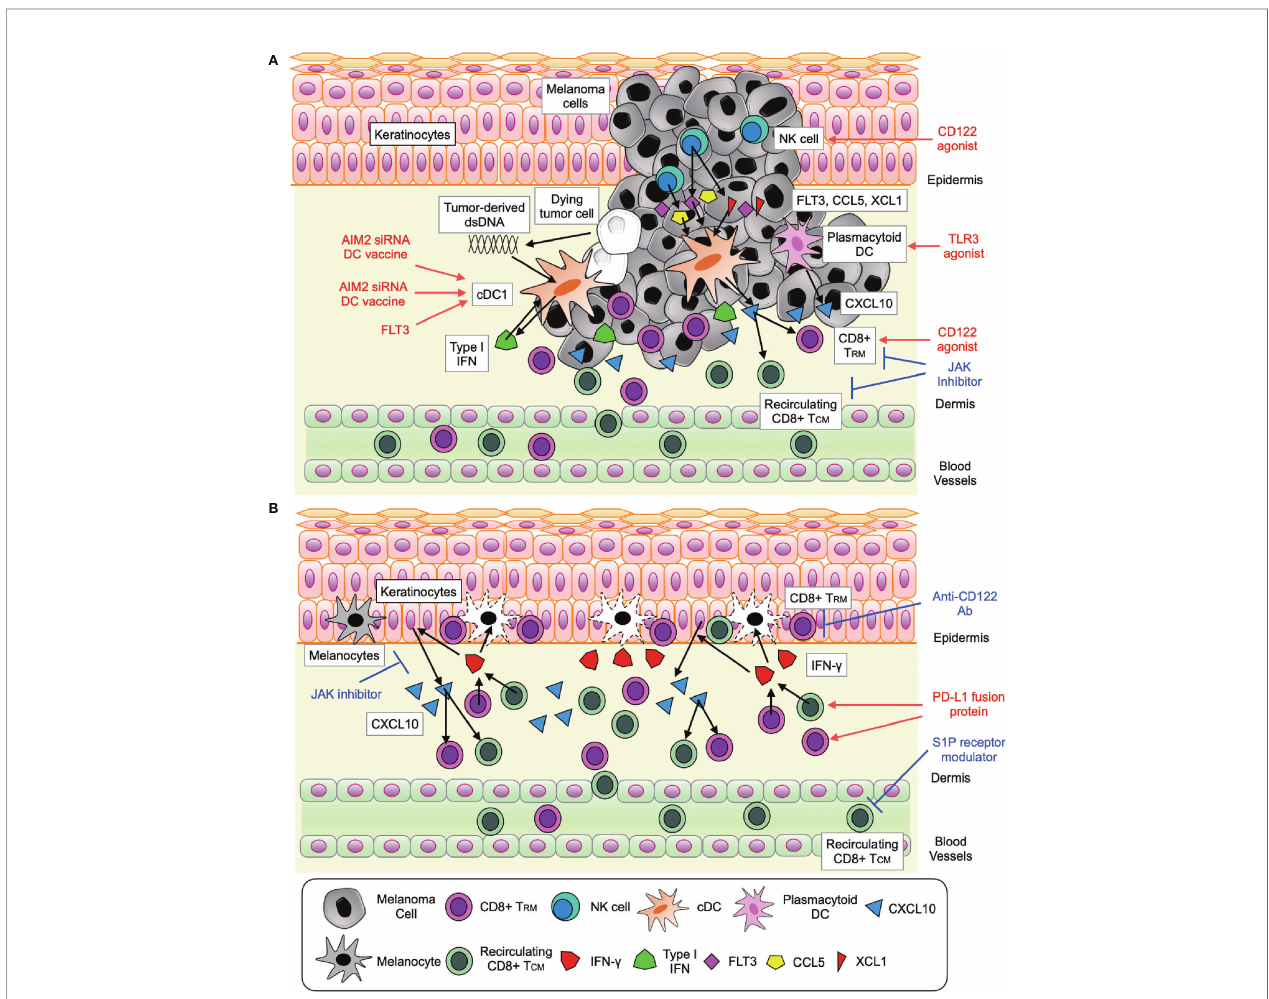
FIGURE 1 | Signaling pathways involved in CD8 + T cell response activation and future therapeutic approaches in melanoma (A) and vitiligo (B) . (A) The interaction of (i) CD8 + T cell (CD8 + T RM and recirculating CD8 + T CM ) with cDC1 and plasmacytoid DC through type I IFN-CXCL10 signaling (ii) NK cell with cDC1 through FLT3, CCL5, and XCL1. (B) The interaction of CD8 + T cell (CD8 + T RM and recirculating CD8 + T CM ) with keratinocytes through IFN- g -JAK signaling and IL-15 (CD122) signaling.